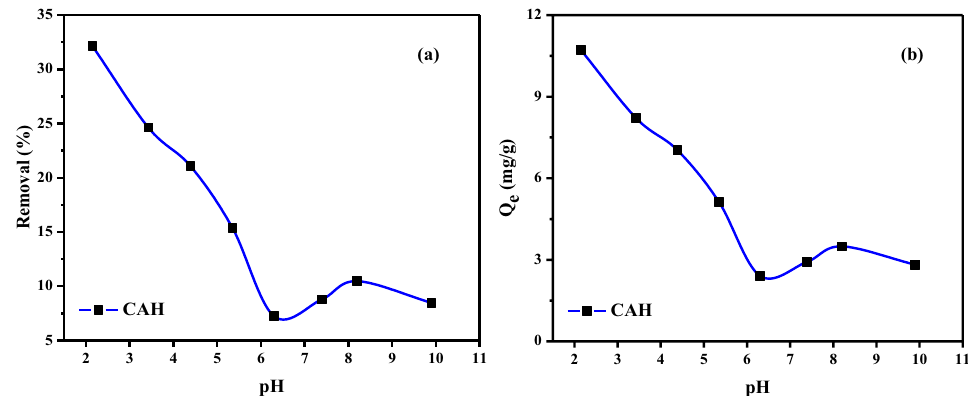
Figure 6. DB86 dye absorption on CAH as a pH impact ( a ) on the removal %; ( b ) on the absorption capacity [DB86 dye (50 ppm), adsorbent (1.5 g/L), time of contact (3 h), shacking (200 rpm), and temp. (27 ± 2 °C)].